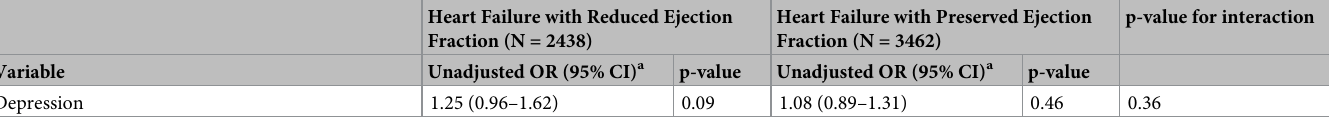
dardized univariate effect sizes were inpatient status, right ventricular basal diastolic diameter, hypertension, blood loss anemia, and pulmonary circulatory disorders.